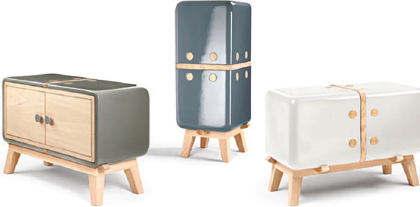
Figure 8: Keramos schematic diagram of ceramic furniture wardrobe combination after image di ff erence